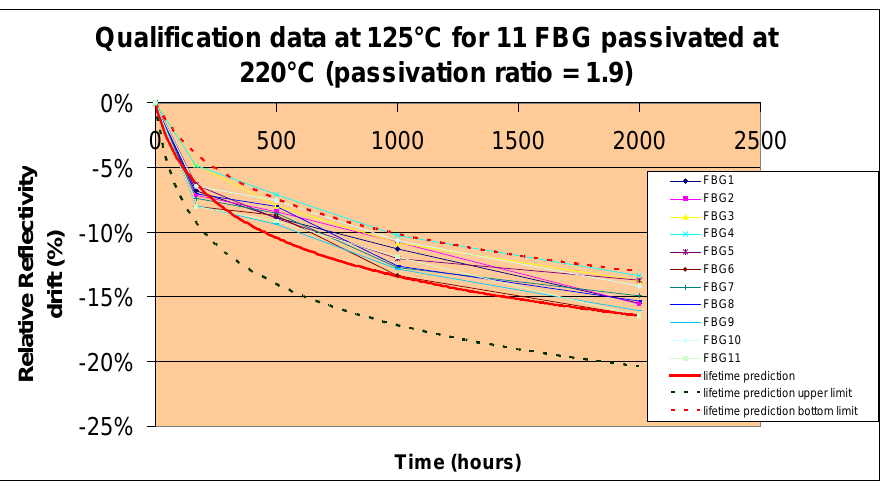
Figure 7. An example of comparison between qualification data ( i.e. , accelerated isothermal ageing) at 125 °C and the lifetime prediction for 11 passivated identical FBG / Δ n was about 1.9 ± 0.1. using the Master Curve (MC). The passivation ratio Δ n 0 1 Qualification data at 125°C for 11 FBG passivated at 220°C (passivation ratio =